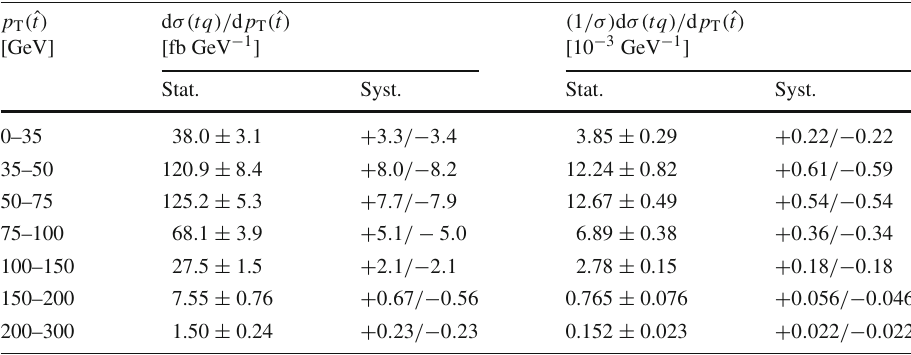
normalised unfolded differential tq production cross-section as a function of p T ( ˆ t ) at particle